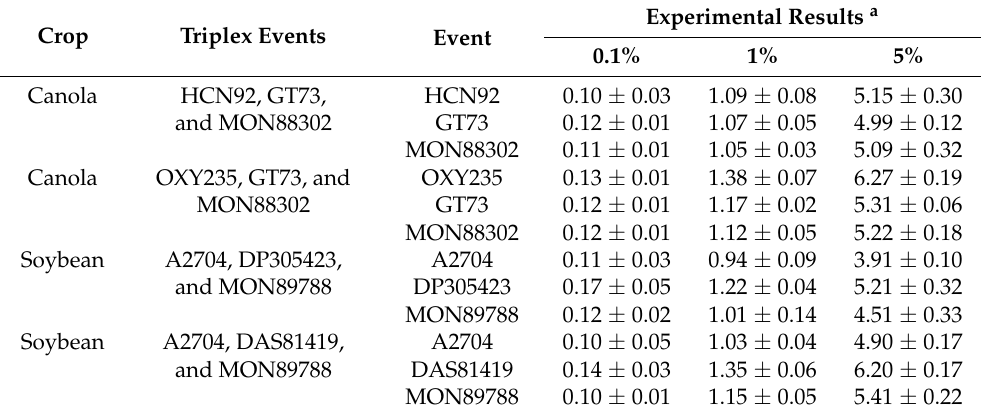
Table 3. Experimental results for triplex ddPCR assays for GM canola and soybean events.